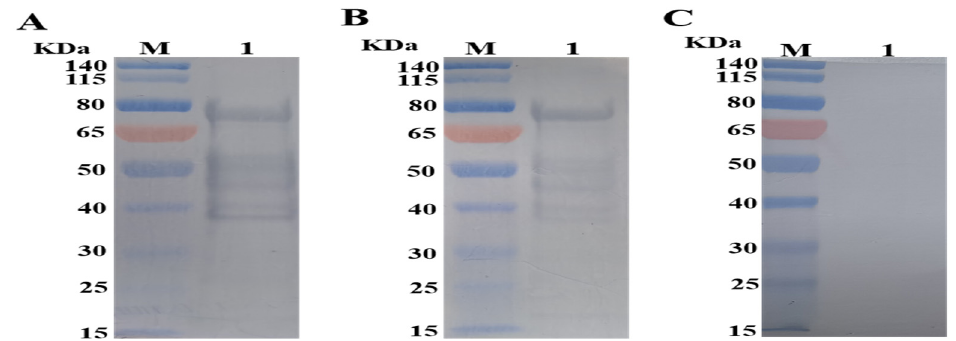
Figure 2. Western blot analysis of rEtROP17 (original Western blot figures are in Figure S1). ( A ) rEtROP17 was probed with mouse anti ‐ His tag monoclonal antibody. ( B ) rEtROP17 was probed ( A ) rEtROP17 was probed with mouse anti-His tag monoclonal antibody. ( B ) rEtROP17 was probed with chicken anti ‐ E. tenella serum. ( C ) rEtROP17 was probed with normal chicken serum. with chicken anti- E. tenella serum. ( C ) rEtROP17 was probed with normal chicken serum.